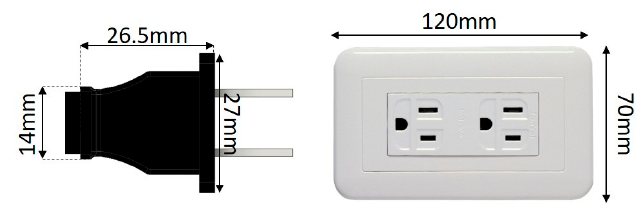
Figure 19. Specifications of the socket and plug.